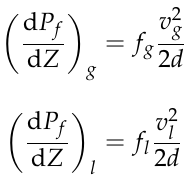
Figure 10. Frictional pressure gradient with inlet velocity at different gas void fractions.